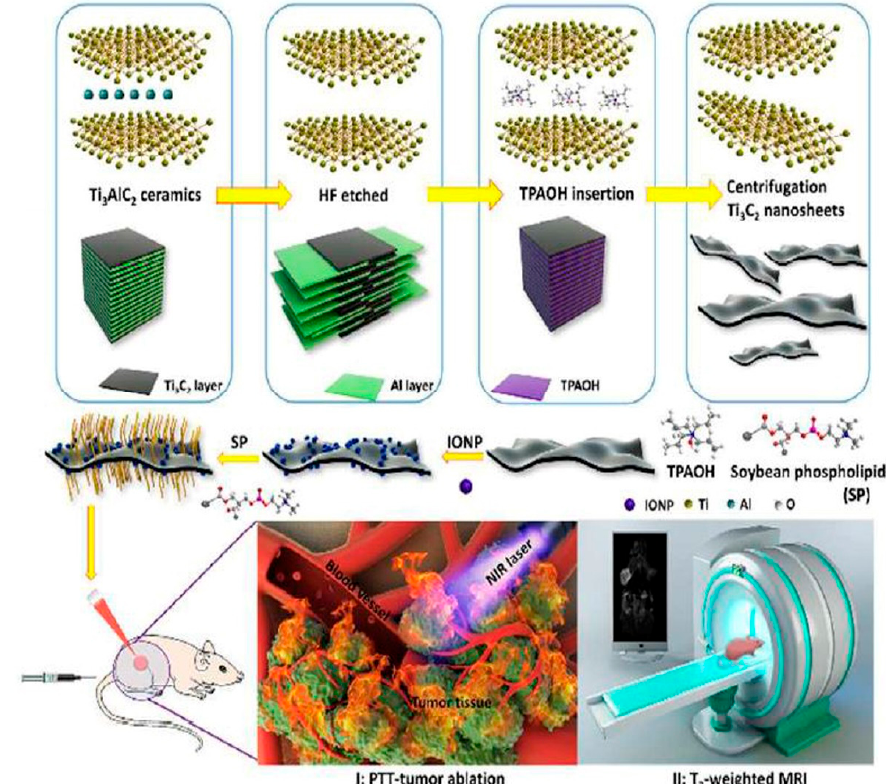
Figure 2. Exfoliation process and surface engineering of magnetic 2D Ti 3 C 2 -IONPs-SPs nanocompos- ites and their multifunctionalities for tumor theranostics. Photoacoustic imaging: PS, and iron oxide nanoparticles: IONP. Reproduced with permission from [60], The Royal Society of Chemistry,